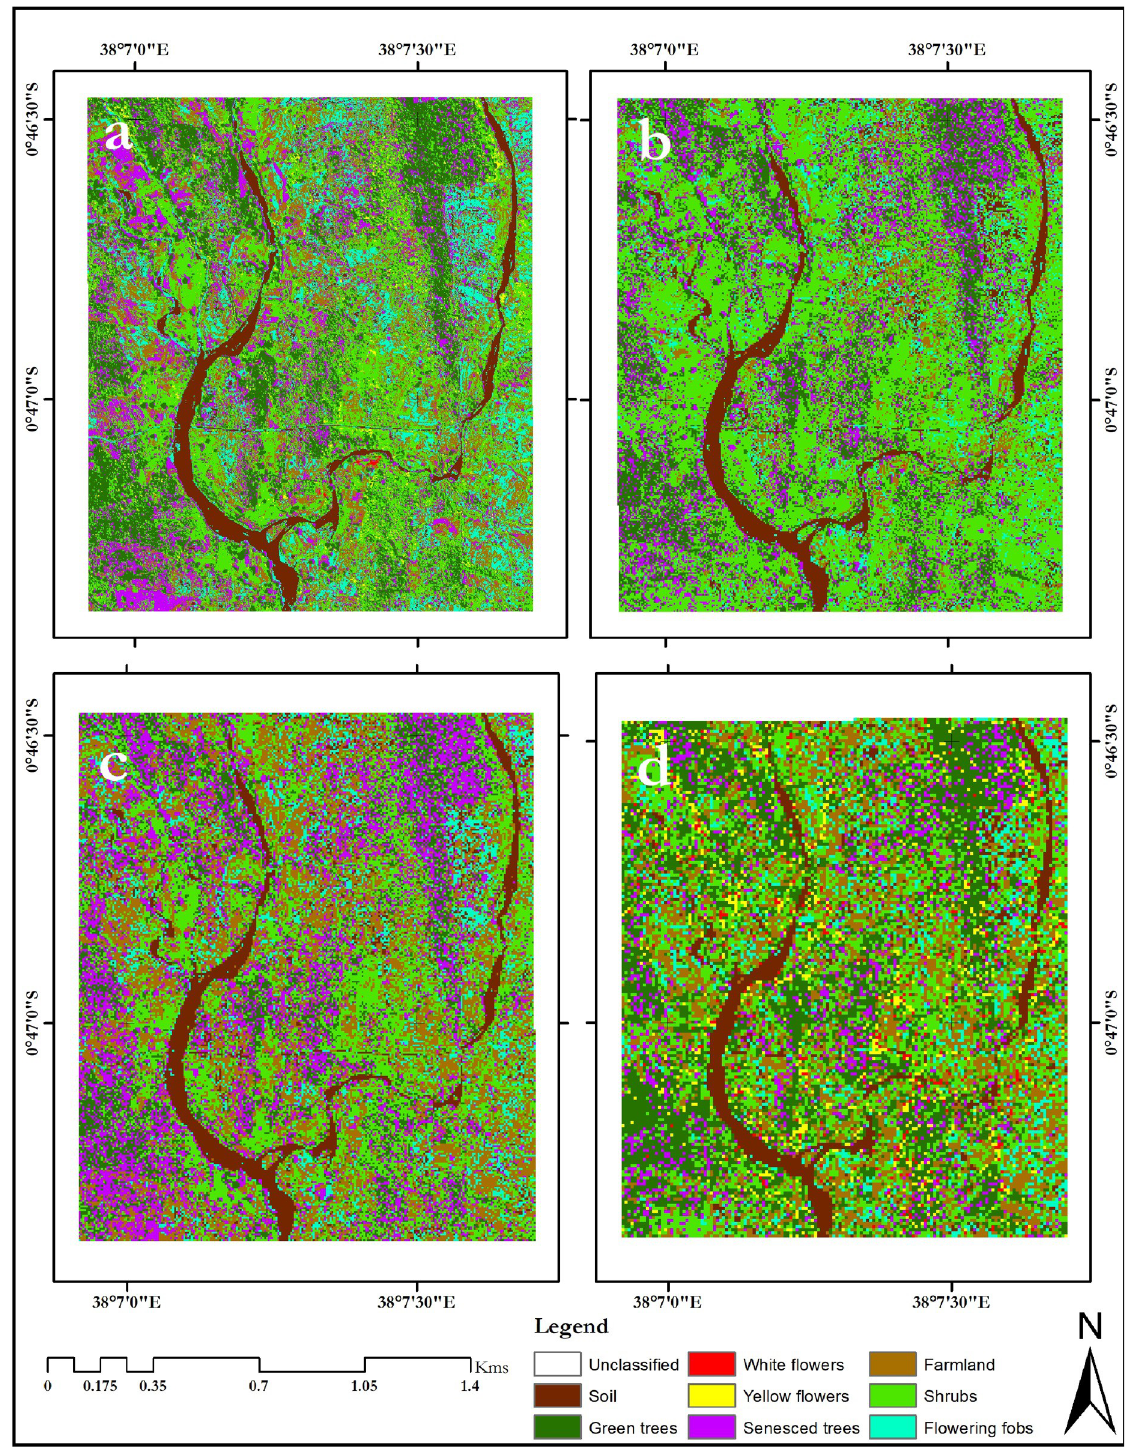
Fig 2. January 2014 classification maps of the Mwingi study site obtained using random forest classifier and resampled simulated WorldView-2 image classification (a), RapidEye (b), Spot-6 (c), Sentinel-2 (d) images. The maps were developed using QGIS software version 3.10 ( https://qgis.org/en/site/ ) [52].